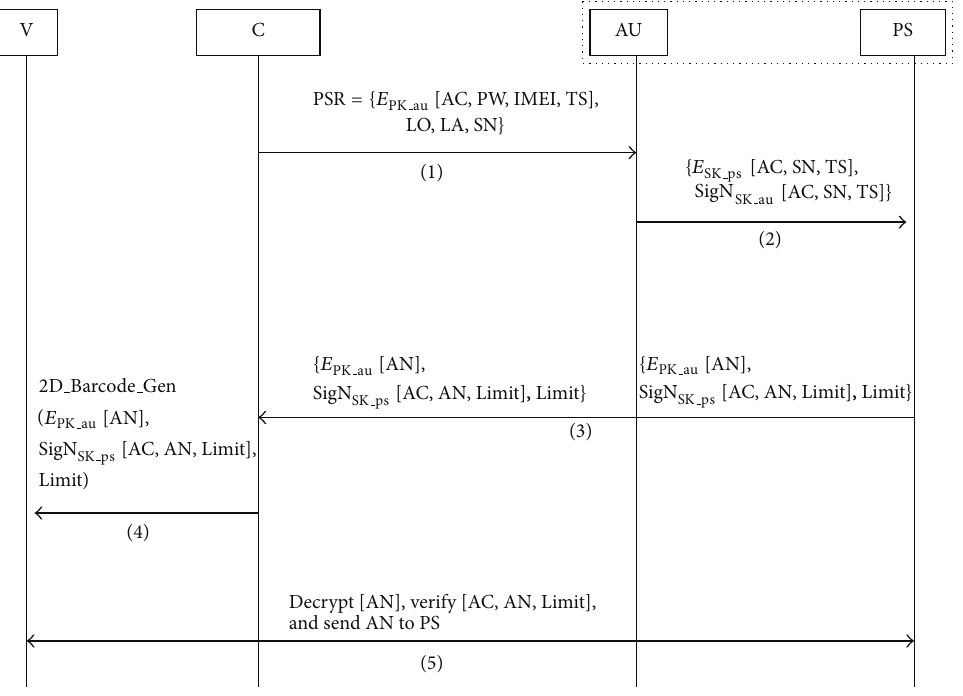
Figure 2: The message exchanges of the operating